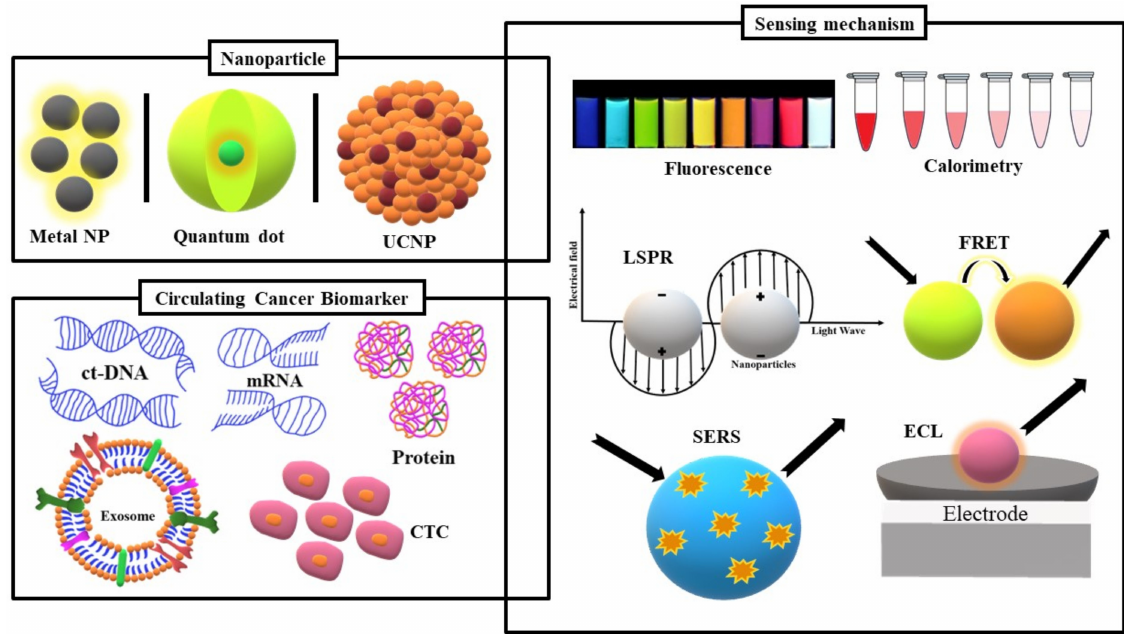
Figure 1. Schematic representation of the nanoparticles and the main sensing mechanisms of circulating cancer biomarkers covered in this